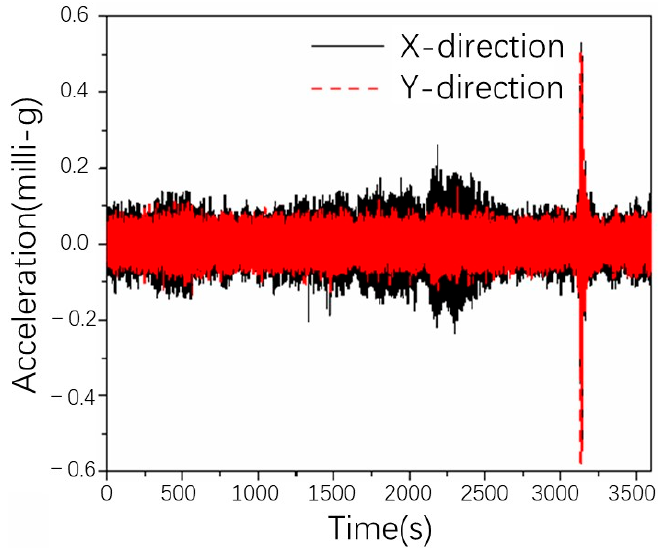
Figure 11. Acceleration response measured atop Canton Tower during the earthquake.